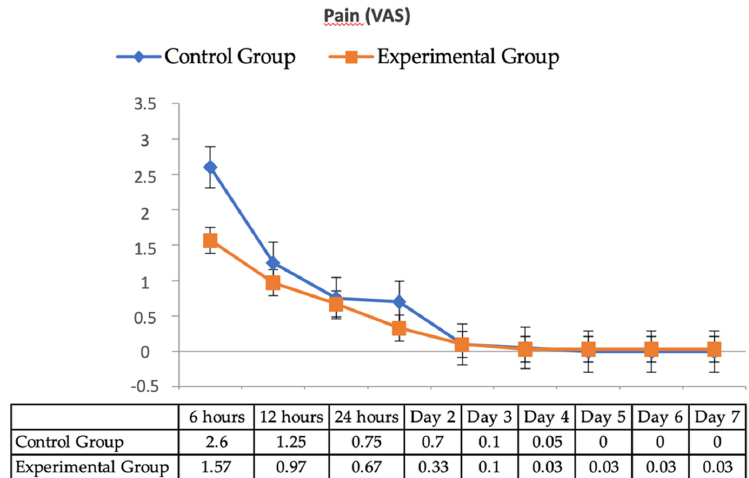
Figure 3. Mean values of pain intensity recorded by VAS.